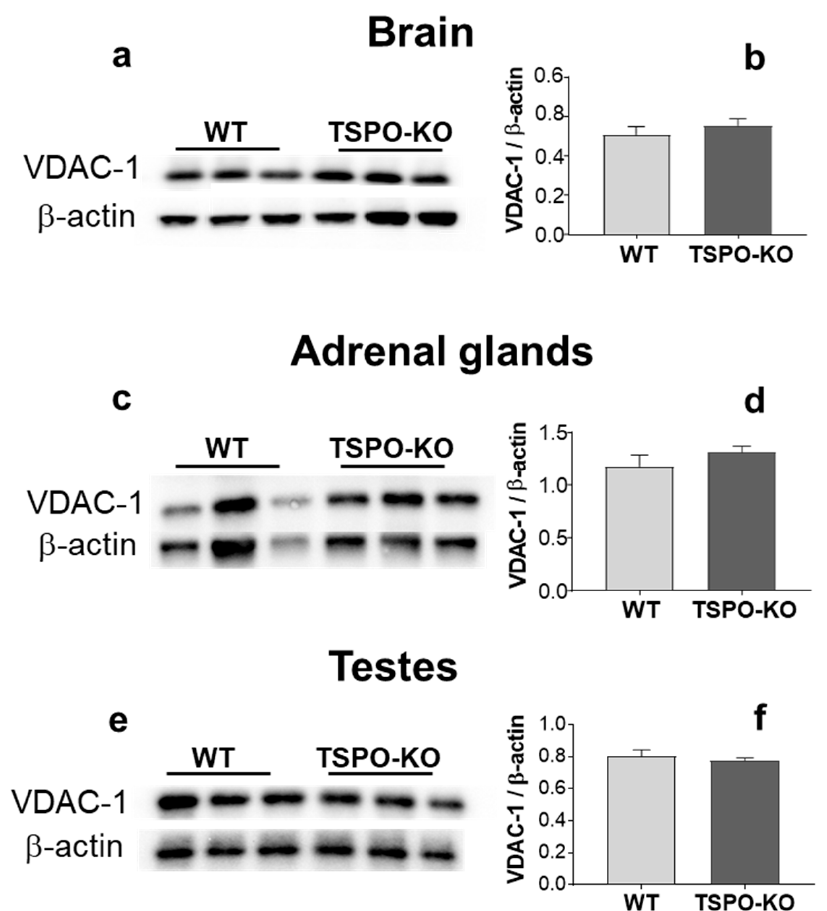
Figure 8. Western blot analysis of VDAC-1 protein levels in the brain, adrenal glands and testes from TSPO-KO and WT mice. Representative bands of VDAC-1 and the loading controls β -actin or GAPDH for all tissues ( a , c , e ) are shown. Quantification of VDAC-1 levels was normalized to the loading control β -actin ( b , d , f ).